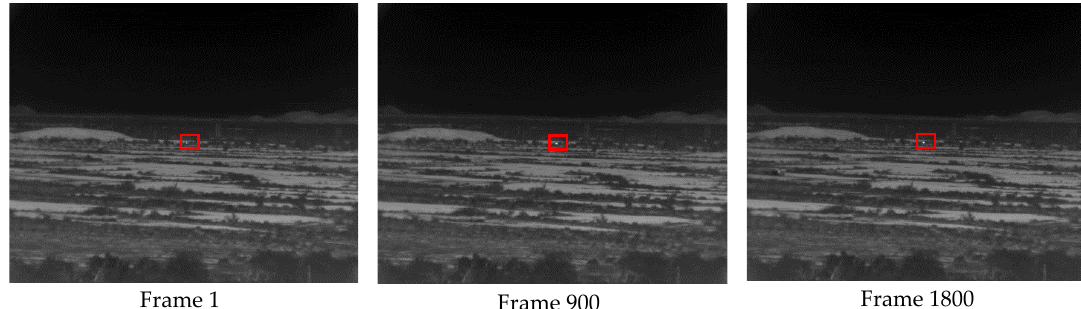
Figure 9. 4500 m daytime videos.